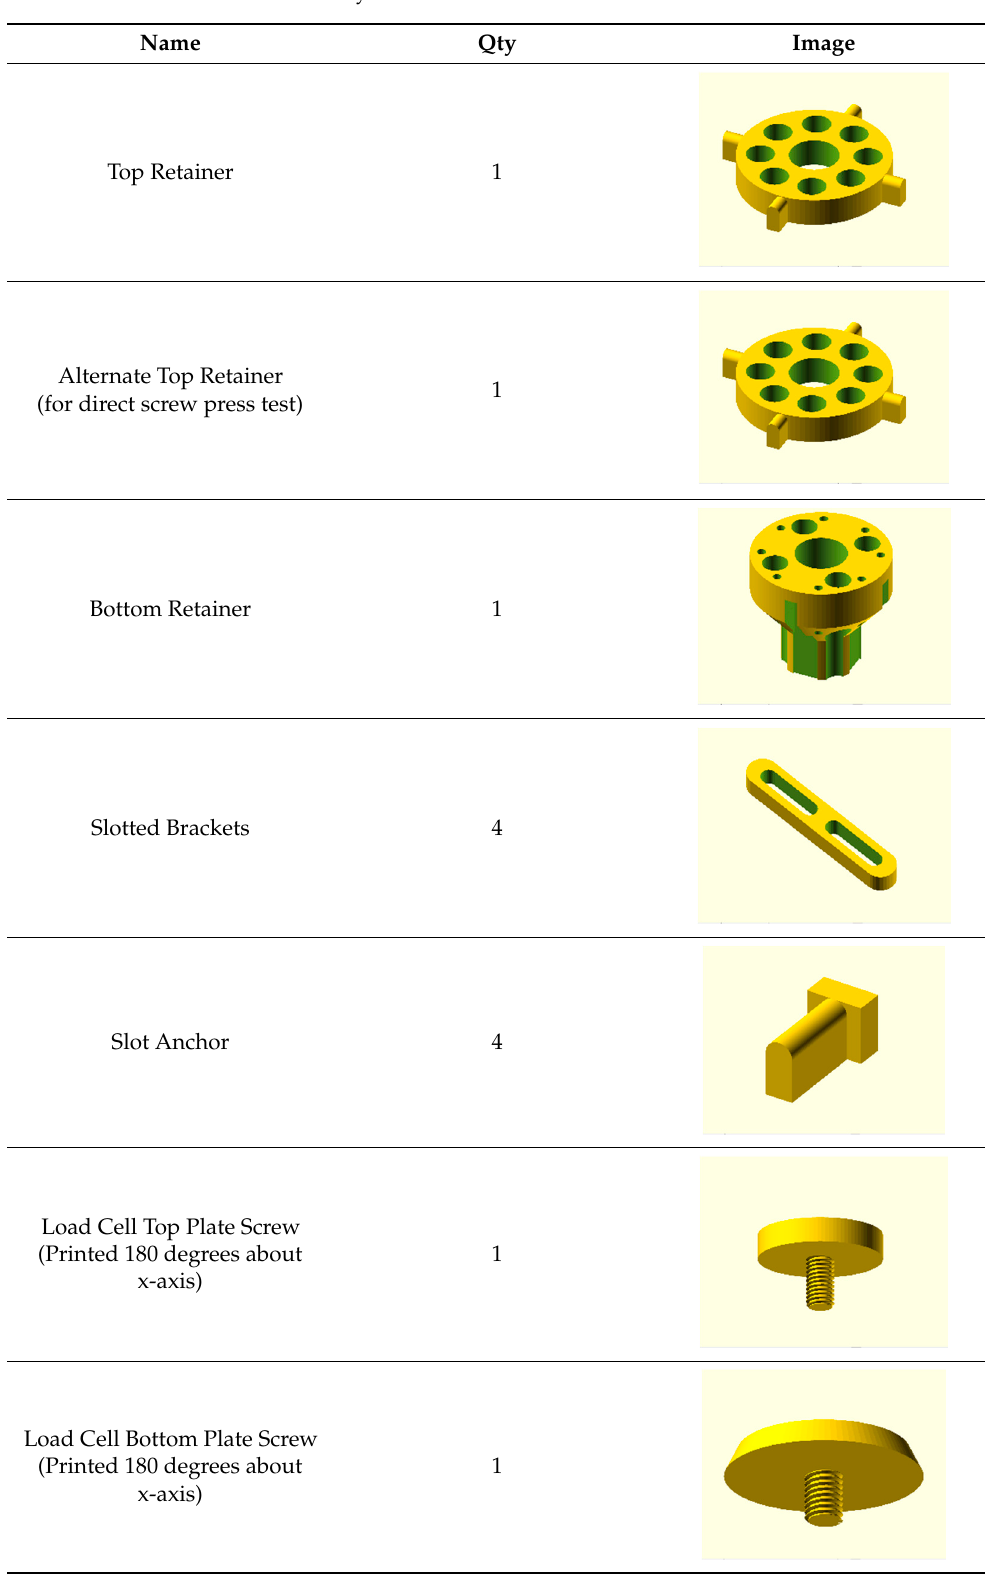
Table 5. BOM of test stand assembly.